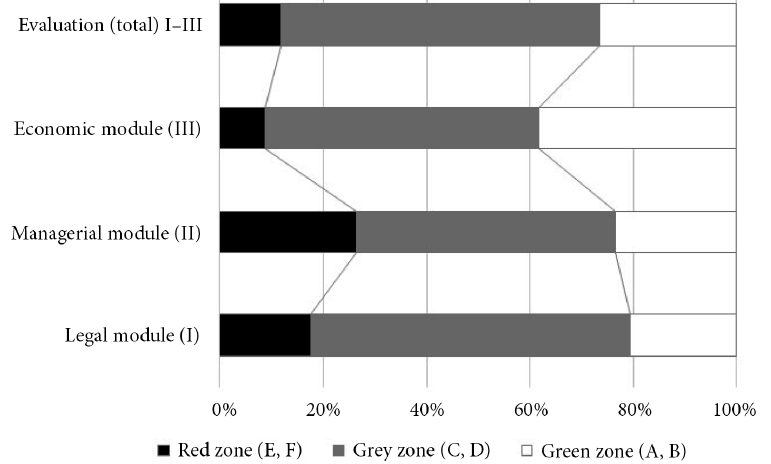
Figure 2. Frequency of companies based on their inclusion in three